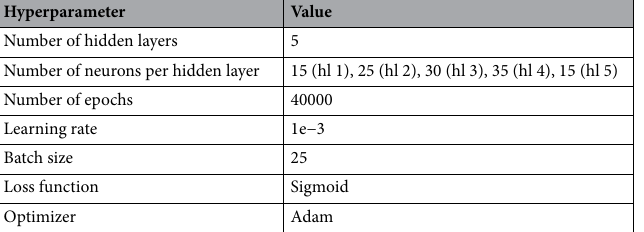
Table 1. Hyperparamters of the neural network for the case study of Groß Schönebeck. Note that hl denotes dense hidden